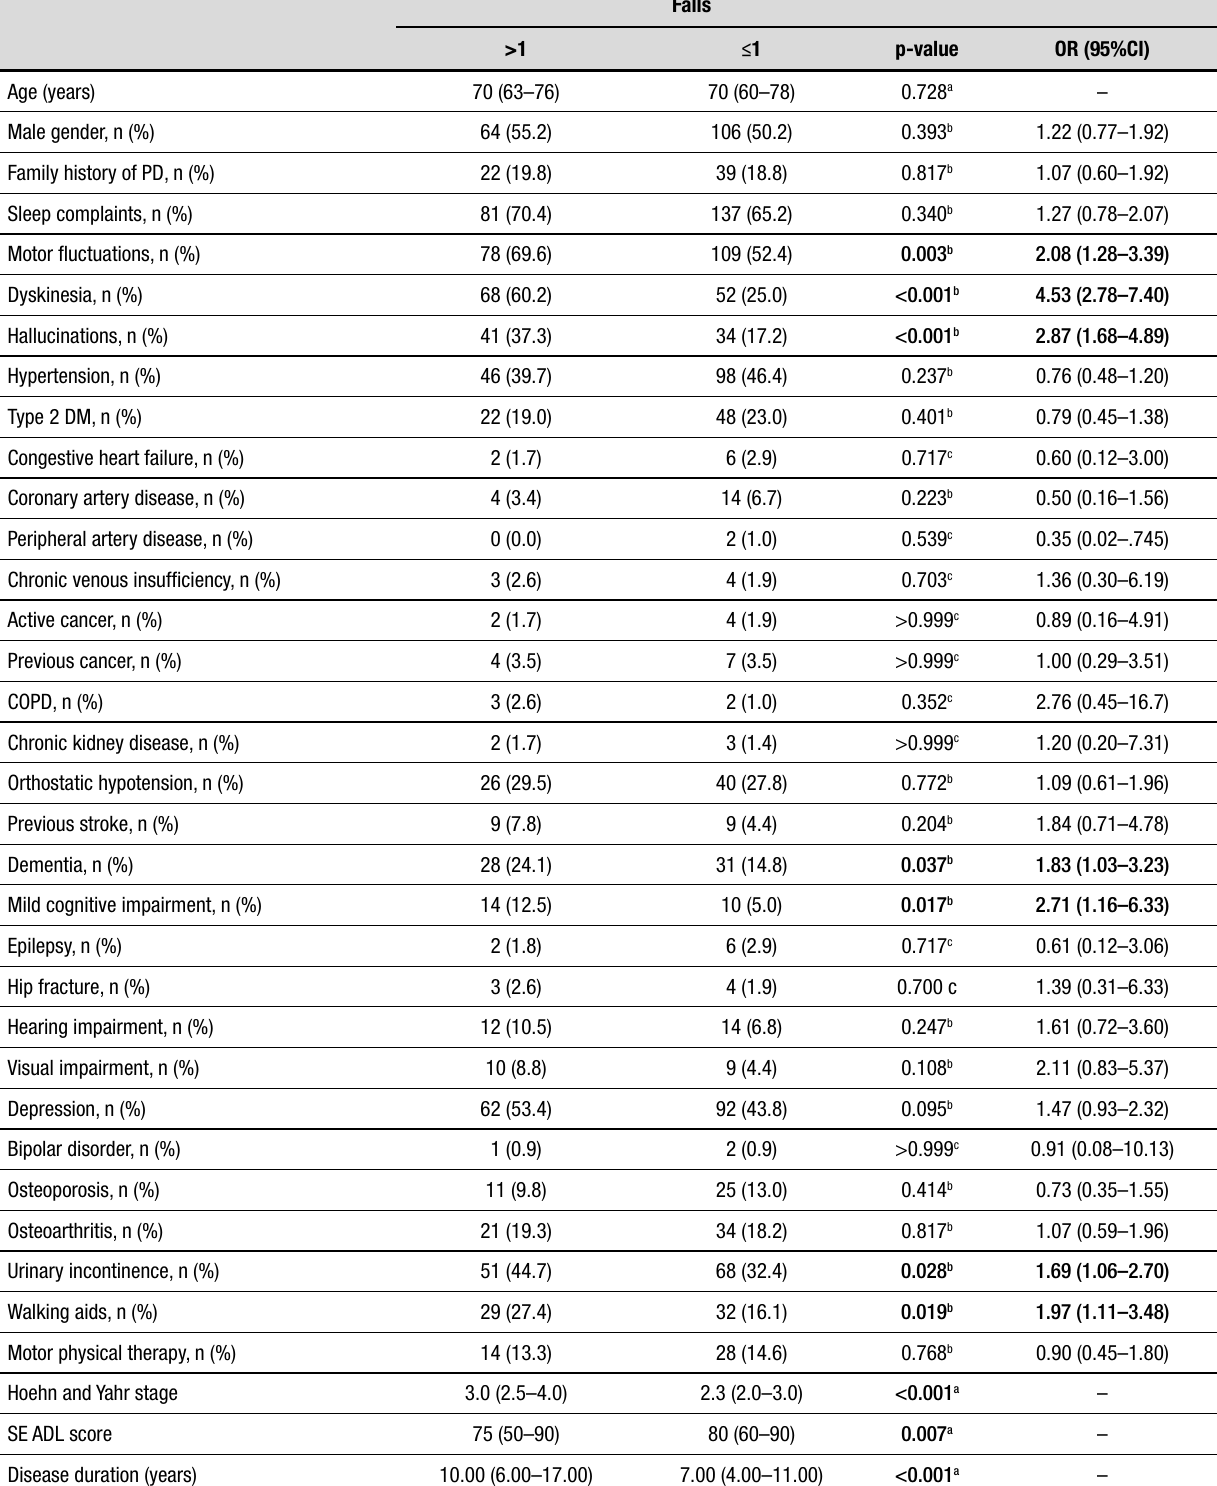
Table 2. Sociodemographic and clinical characteristics of occasional and recurrent fallers among patients with Parkinson’s disease.